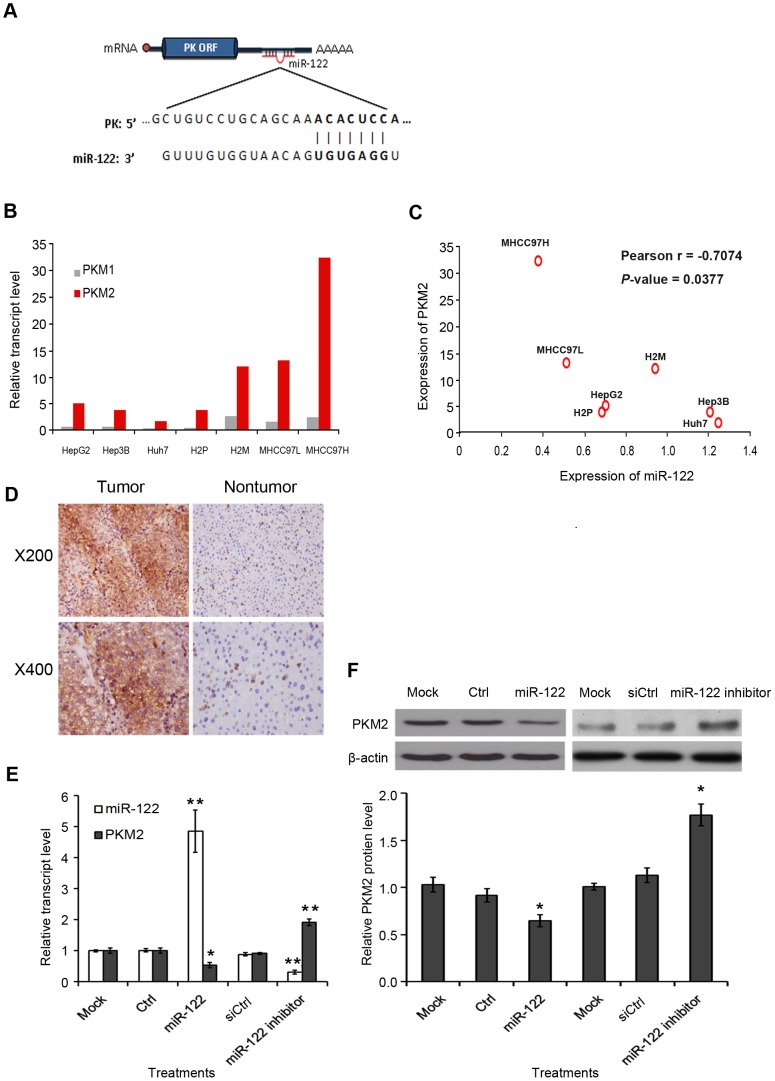
PKM2 is a direct target of miR-122.
(A) Predicted binding interaction between 3’UTR of PK and miR-122. (B) Expressions of PKM1 and PKM2 in HCC cell lines, as detected by qPCR method. (C) Expression correlation of PKM2 and miR-122 in a panel of HCC cell lines. (D) Immunohistochemical staining of anti-PKM2 antibody in paired tumor and adjacent nontumor tissue. A total of 12 tumor/nontumor tissue pairs were tested, and representative photomicrographs are shown. (E) Expression level of PKM2 mRNA and miR-122 levels in Ctrl, miR-122, siCtrl or miR-122 inhibitor treated HepG2 cells. Mock: transfection reagent only; Ctrl: transfection with empty-vector; miR-122: transfection with pc-miR-122; siCtrl: transfection with non-targeting siRNA; miR-122 inhibitor: transfection with miR-122 inhibitor. Data were derived from three independent experiments. (F) Immunoblots (upper panel) of protein level of PKM2 after transfection of miR-122 or miR-122 inhibitor in HepG2 cells. The intensities are quantified and represented in the graph in lower panel. Data were derived from two independent experiments. *p<0.05, **p<0.01, Error bars represent S.E.M.